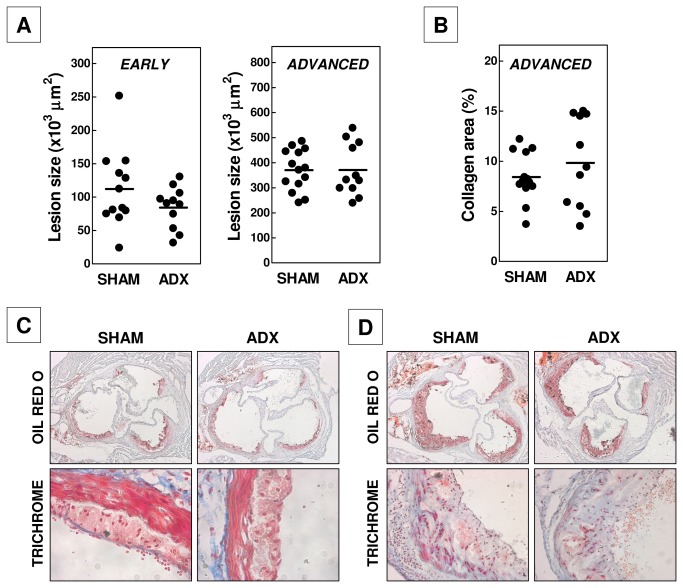
Adrenalectomy does not alter the size (A) or collagen content (B) of atherosclerotic lesions in APOE knockout mice.Representative neutral lipid (Oil red O) and collagen (Trichrome: blue) stainings of early (C) and advanced (D) aortic root lesions. Separate dots in figures A and B represent values for each individual mouse, while horizontal lines indicate the respective group averages.